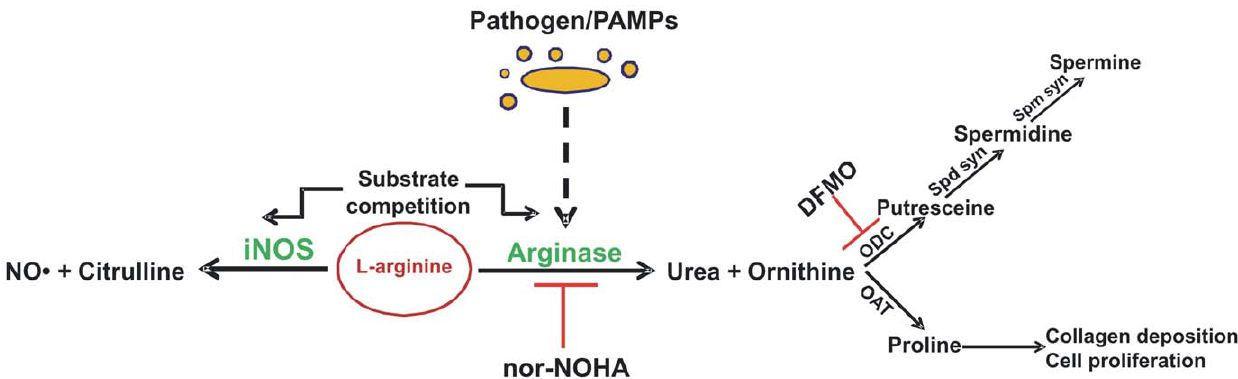
Figure 1. Overview of mammalian arginine metabolism. Only enzymes that directly use or produce arginine, ornithine, or citrulline are identified, and not all reactants and products are shown. Inhibition of specific enzymes is indicated by H . DFMO, difluoromethyl ornithine; iNOS, inducible nitric oxide synthase; NO, nitric oxide; nor-NOHA, nor-N v -hydroxy-l-arginine; OAT, ornithine aminotransferase; ODC, ornithine decarboxylase; PAMPs, pathogen-associated molecular patterns; Spd Syn, spermidine synthase; Spm Syn, spermine